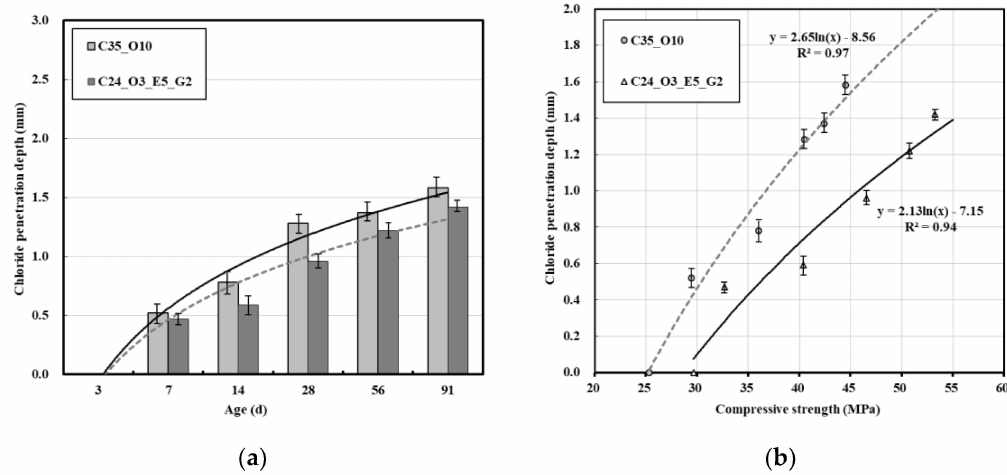
Figure 9. ( a ) Chloride penetration depth by age; ( b ) relation between compressive strength and chloride penetration depth.